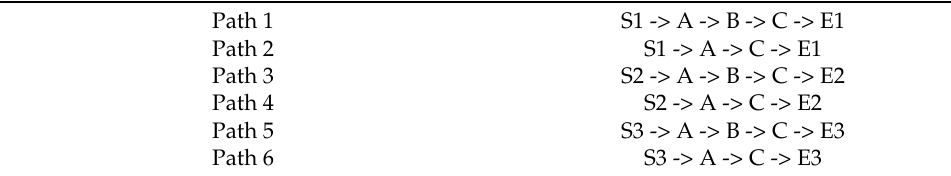
Table 1. Initial information of network.